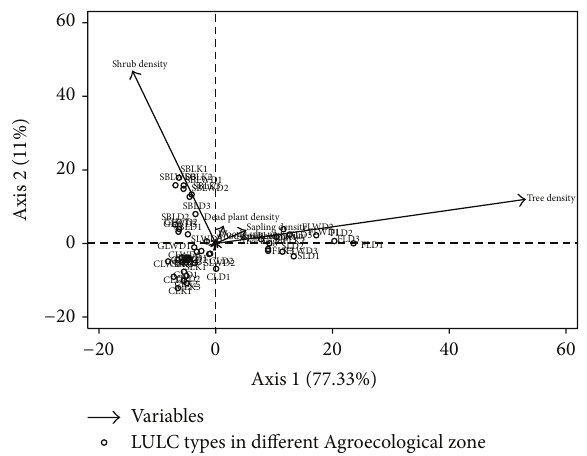
Figure 3: Principal component analysis biplot of measured vegeta- tion variables from the 135 Sample plots in Gilgel Tekeze catchment of LULC types across three agroecological zones (see Table